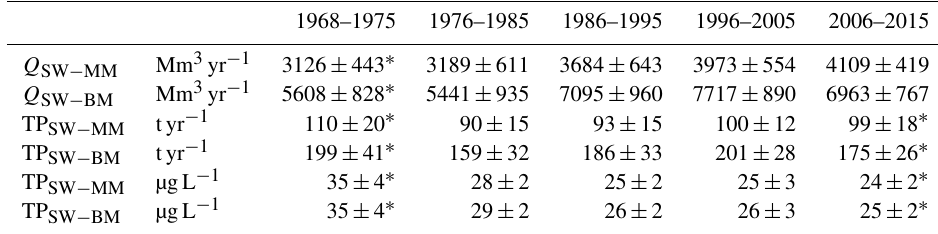
Table 2. Period means of modelled annual water inflow (Q), total phosphorus (TP) input, and volume-weighted input TP concentrations ( ± standard deviation). SW: inflowing salt water from the middle archipelago; MM: mean model; BM: boundary